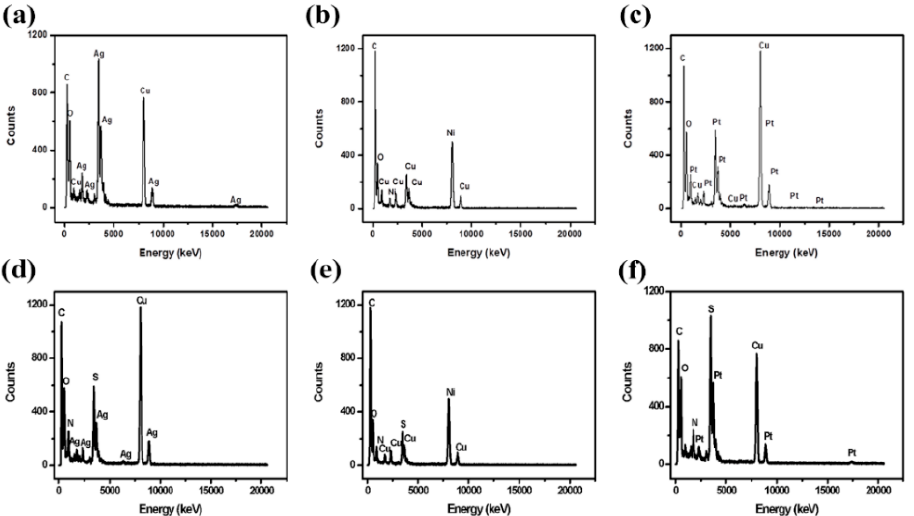
Figure 5. EDS images of ( a ) GO–Ag NPs, ( b ) GO–Cu NPs, ( c ) GO–Pt NPs, ( d ) GO/Ag/DBSA–PANI, ( e ) GO/Cu/DBSA–PANI and ( f ) GO/Pt/DBSA–PANI.